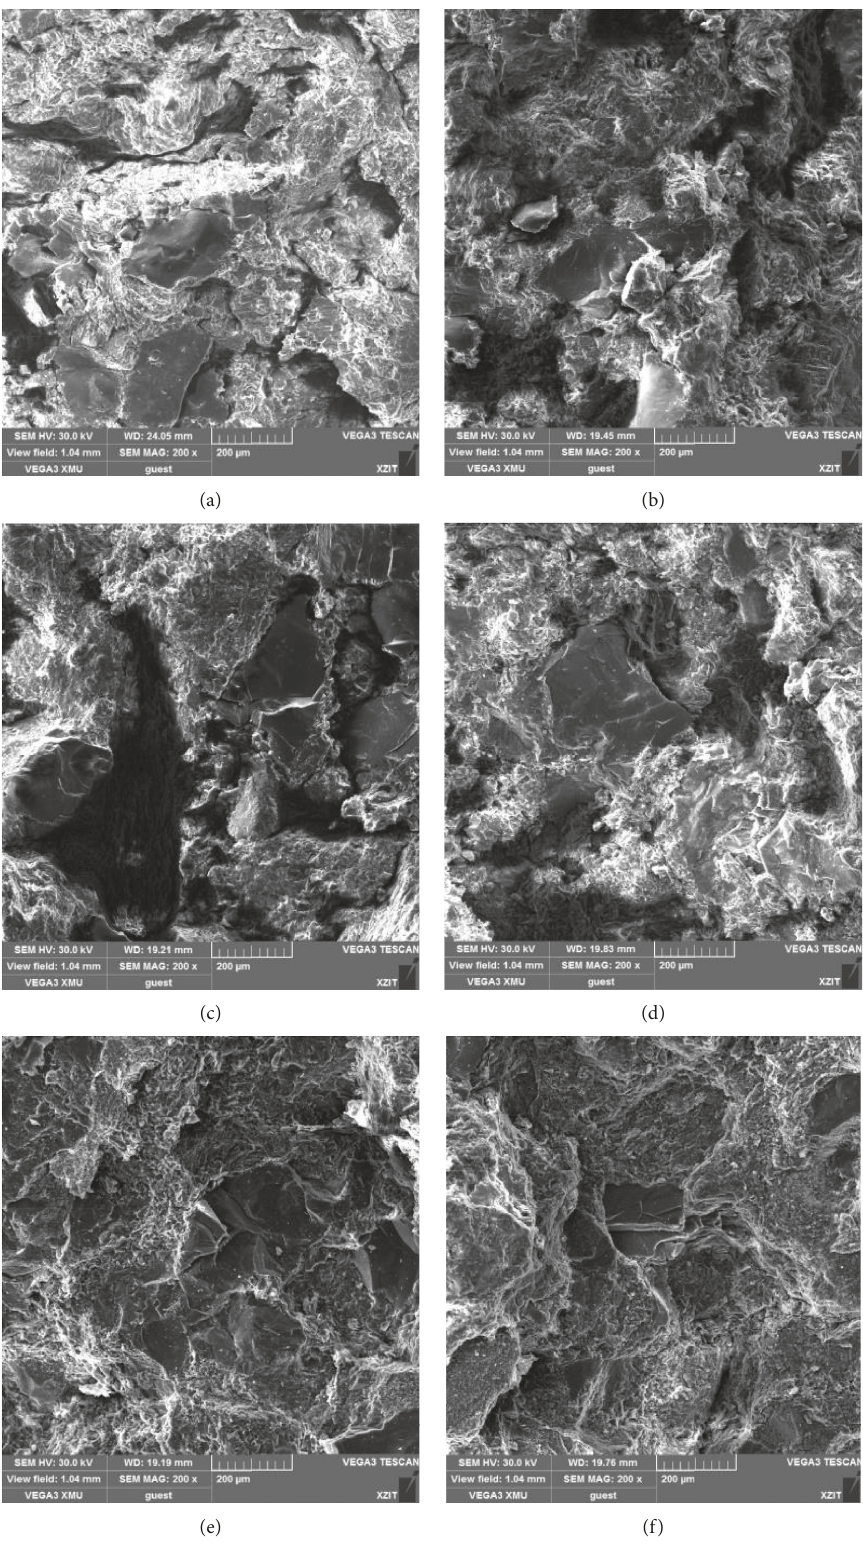
Figure 13: Fracture sections of specimens with different water contents: (a) ω � 0.00%; (b) ω � 0.31%; (c) ω � 0.54%; (d) ω � 0.71%; (e) ω � 0.93%; (f) ω �